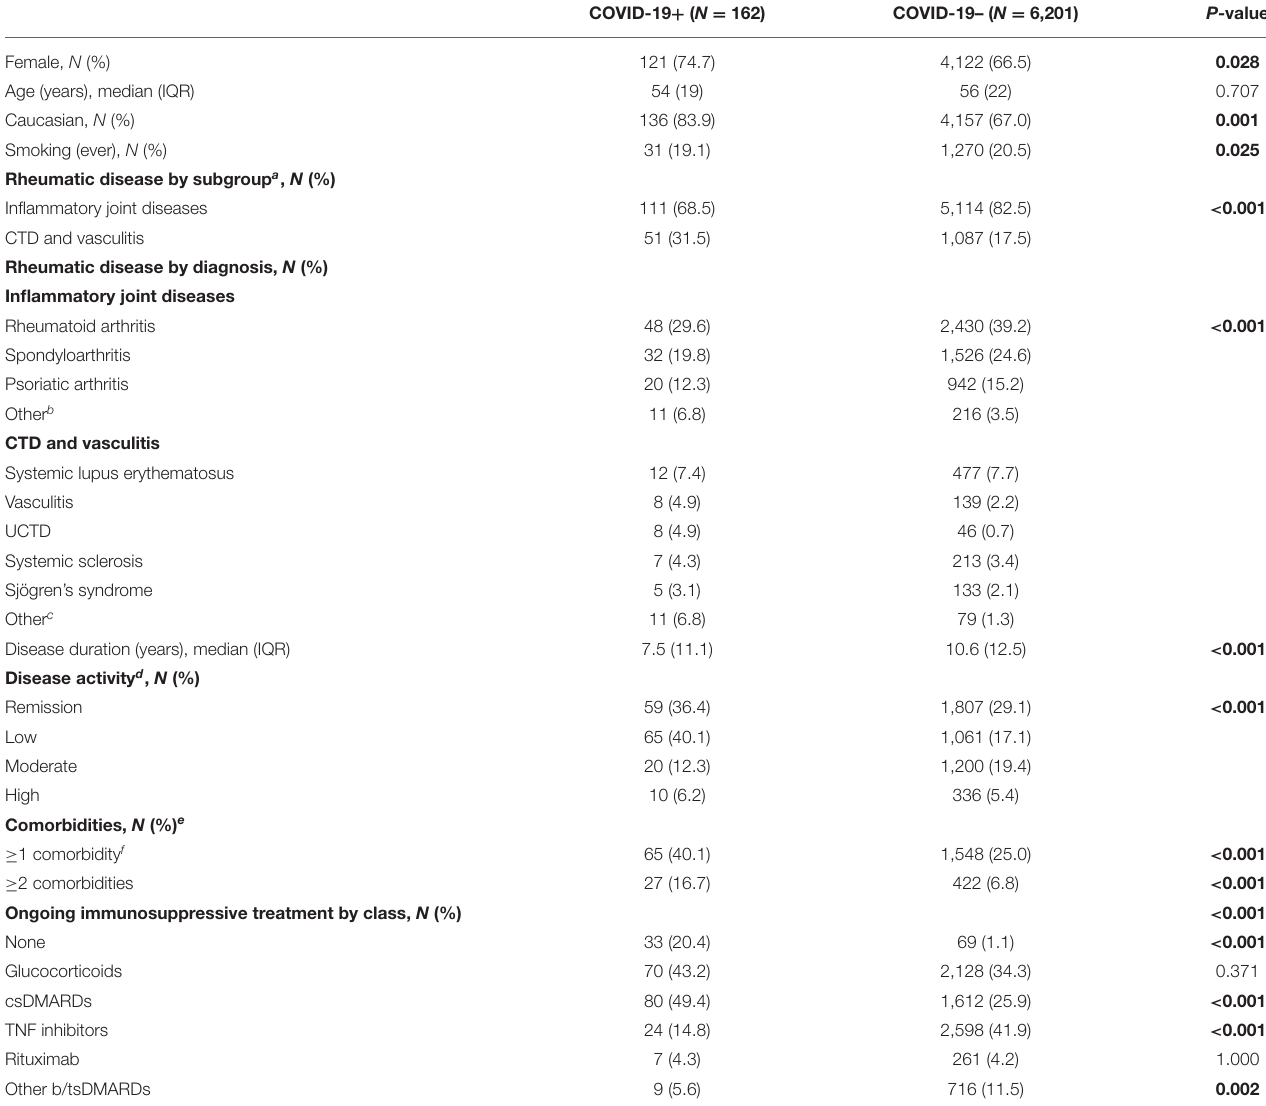
TABLE 1 | Patient characteristics according to COVID-19 status.